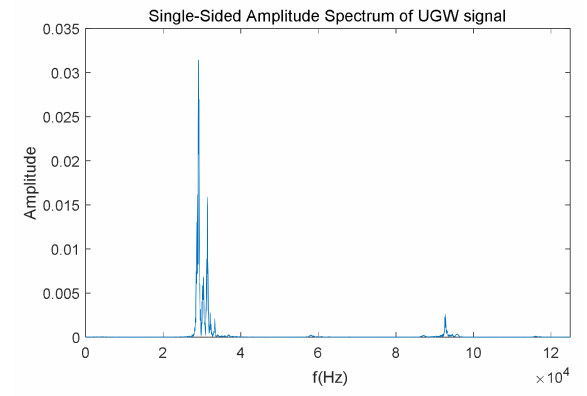
Figure 7. Example of the FFT for the train of UGW pulses shown in Figure